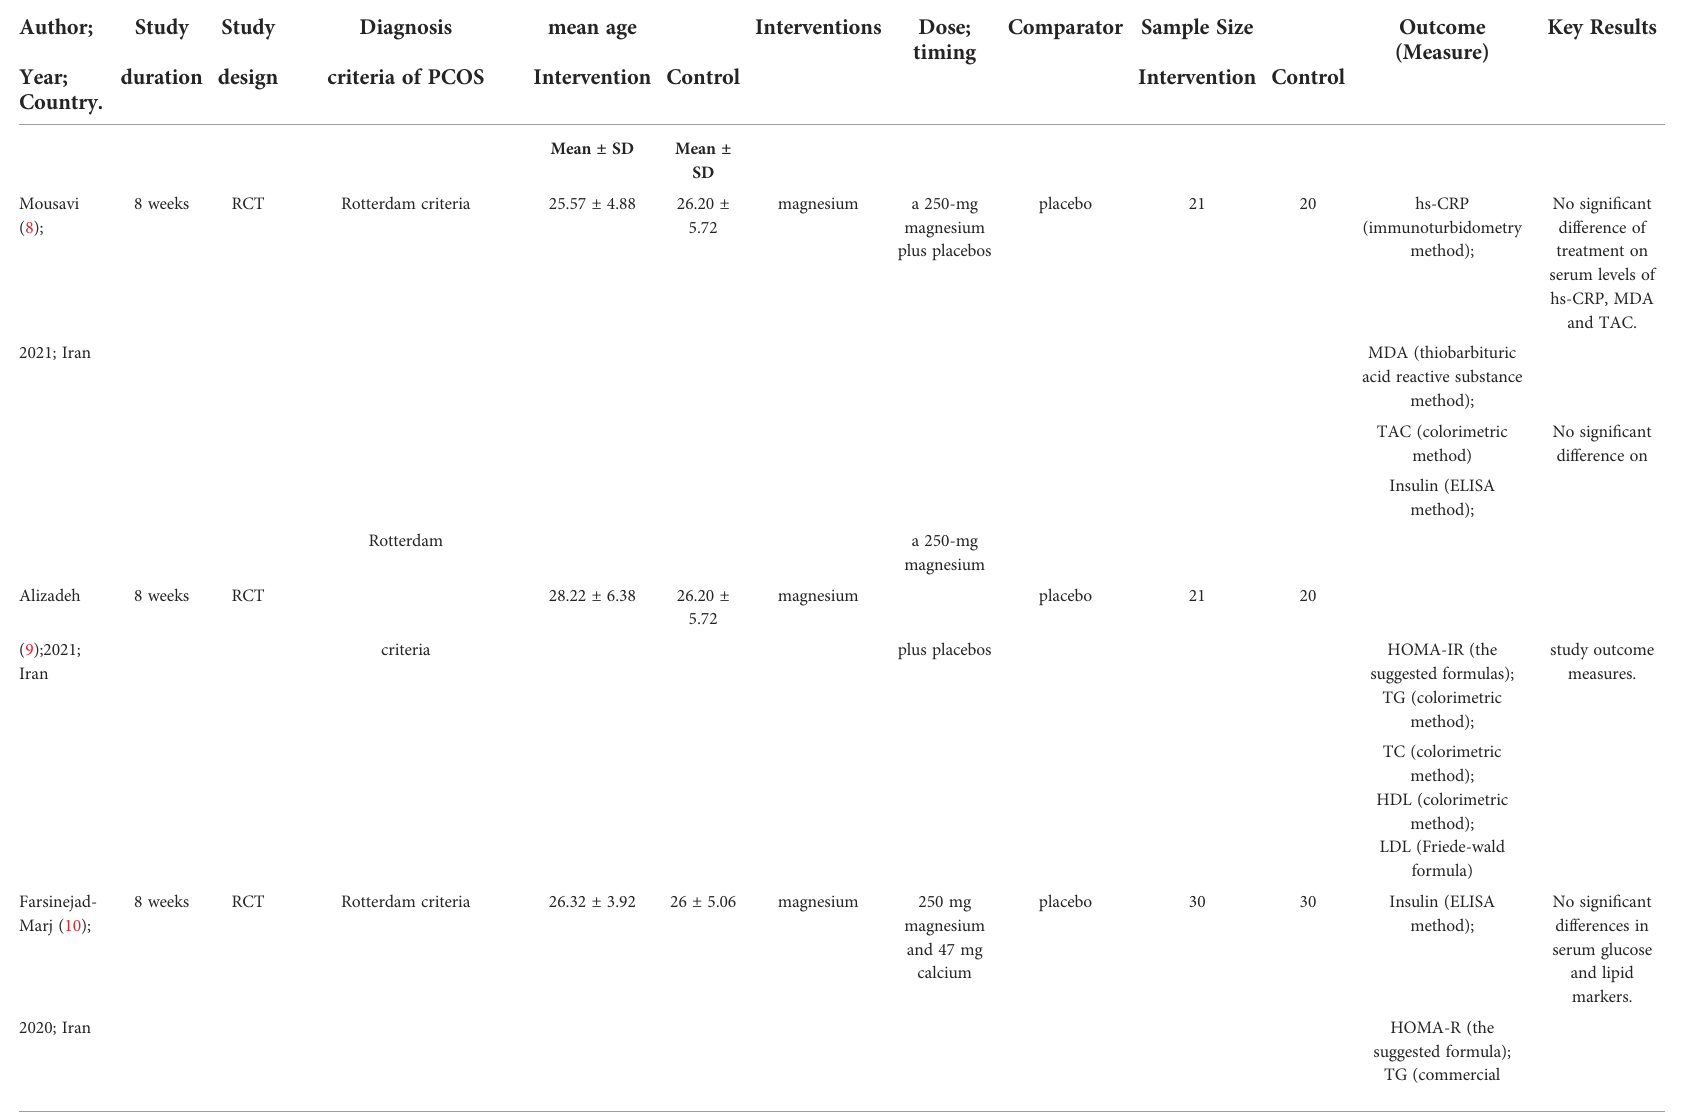
TABLE 1 Summary the characteristics of studies on the impact of magnesium supplementation alone on PCOS.